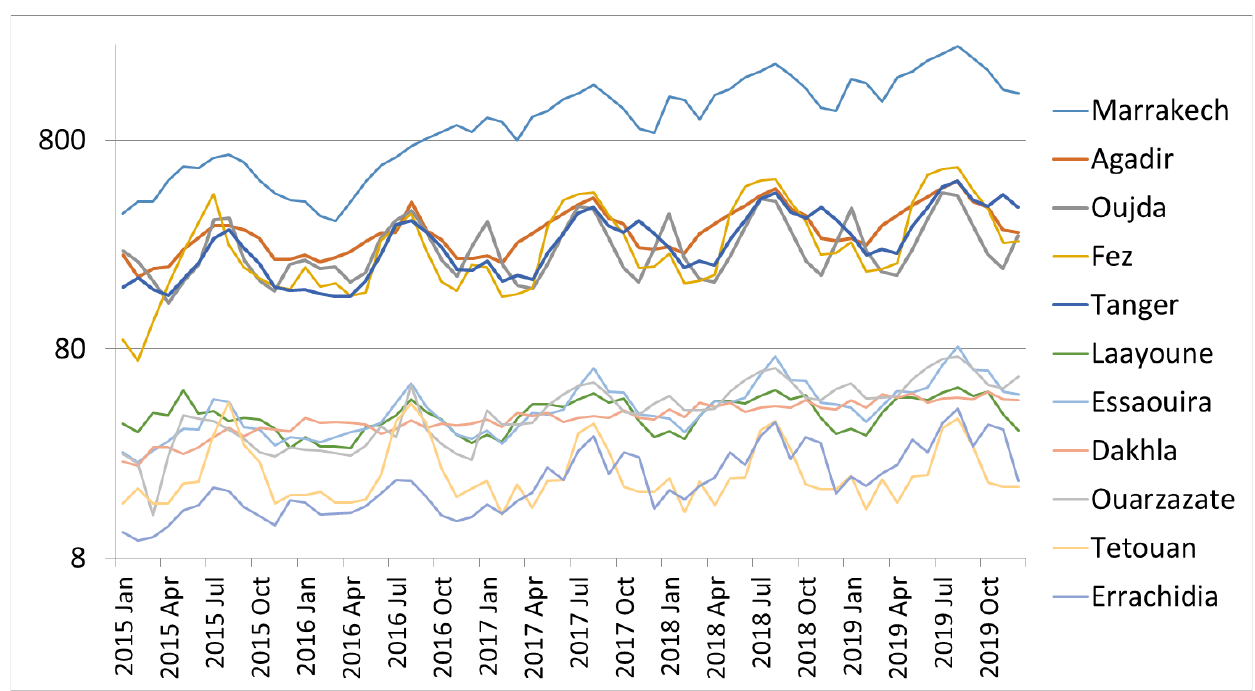
Figure 5. Monthly electricity consumption (MWh) on logarithmic scale at airports: historical 2015–2018; predicted 2019.